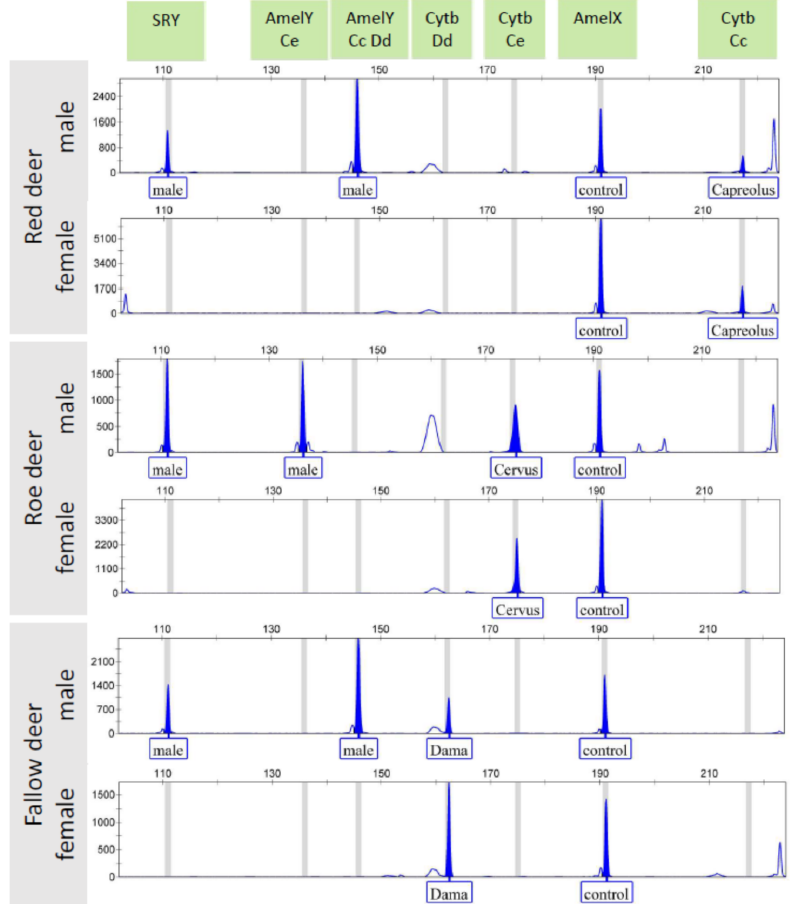
Figure 2. Parallel capillary electrophoresis detection of the PCR products amplified separately by DeerSex-plex and DeerSpec-plex assays for three cervid species. AmelY Ce: Amelogenin Y marker specific for red deer, AmelY Cc Dd: Amelogenin Y marker specific for roe deer and fallow deer, Cytb Dd: cytochrome b marker specific for fallow deer ( Dama dama ), Cytb Ce: cytochrome b marker specific for red deer ( Cervus elaphus ), Cytb Cc: cytochrome b marker specific for roe deer ( Capreolus capreolus